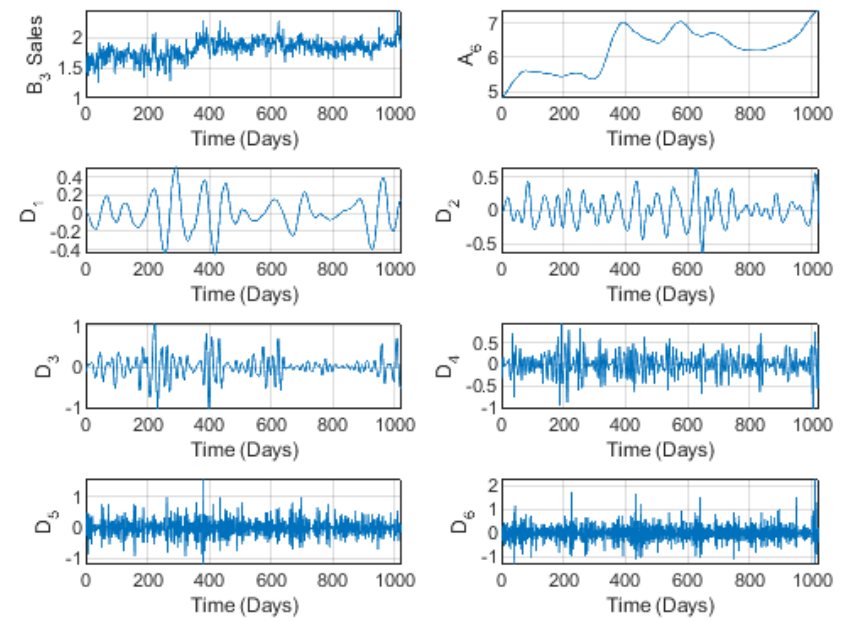
Figure 6. The wavelet decomposition of the STC brand B 3 sales at level